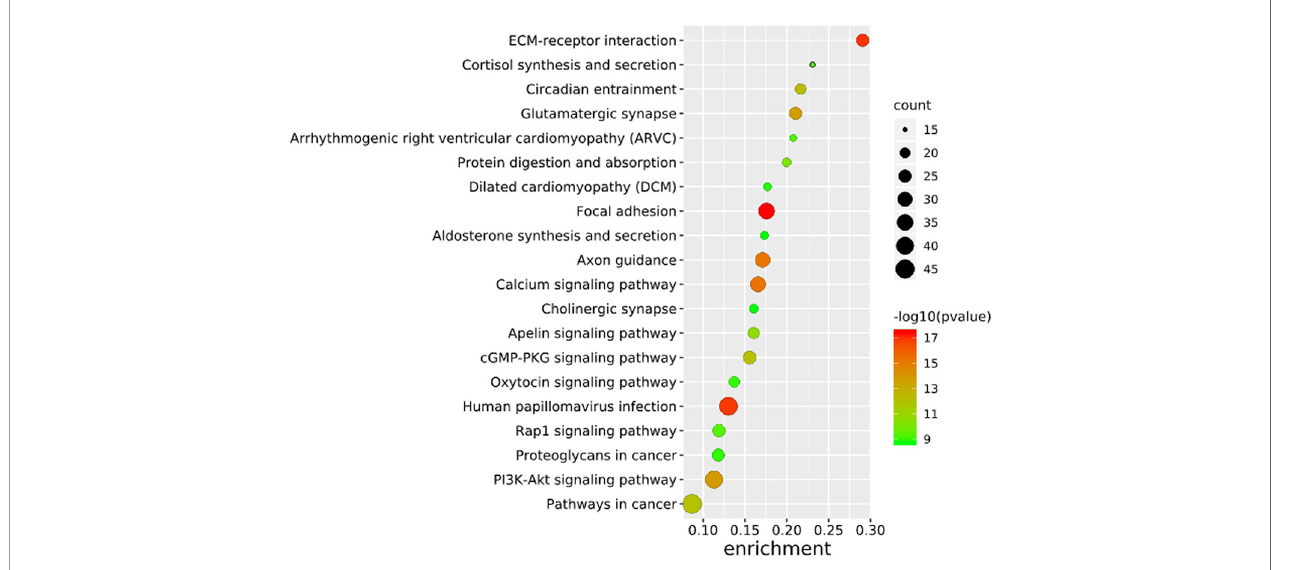
FIGURE 3 | Pathways enrichment map of 945 mutant genes. The top 20 terms with the lowest P value were selected. Count: the number of enriched genes in each term.